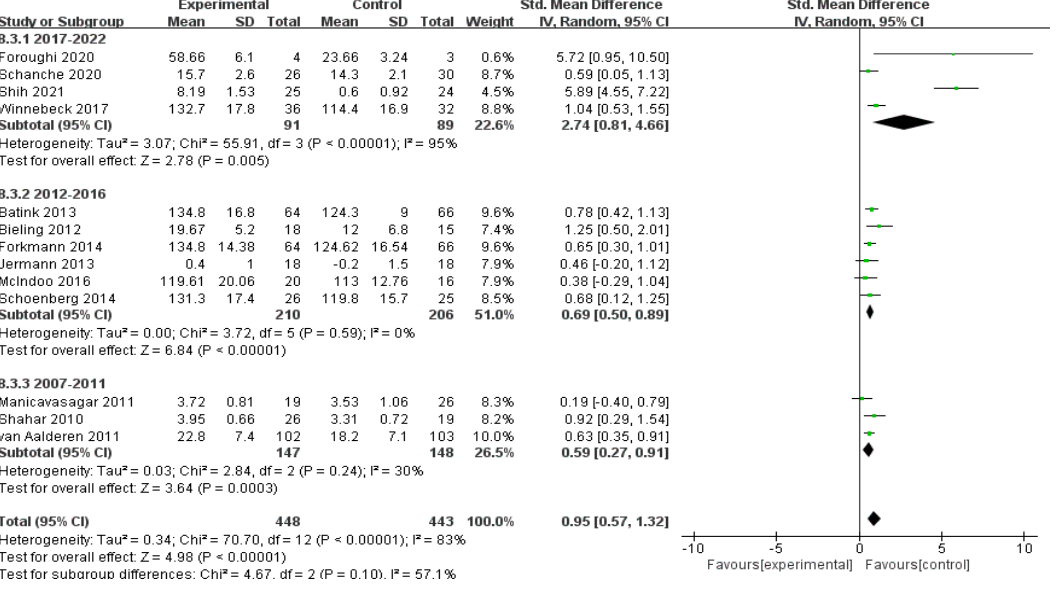
Figure 6. Meta − analyses of the effects of MBIs on mindfulness between years of publication [30–